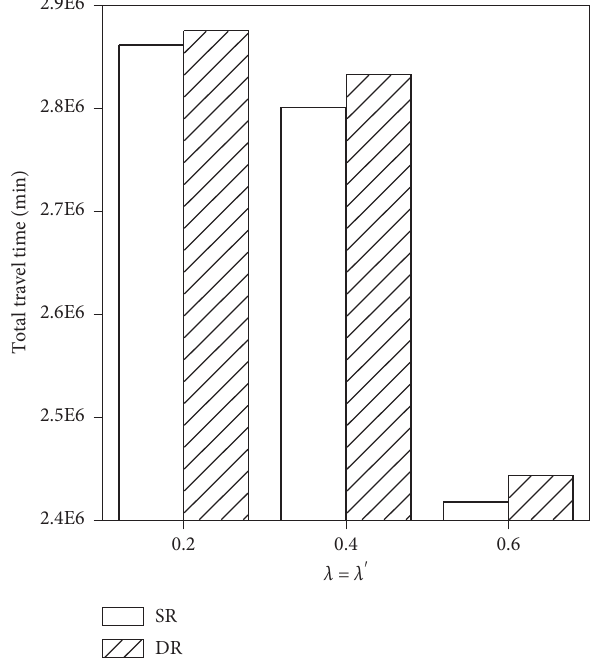
Figure 6: System efficiencies under static and dynamic adjustment ratios.